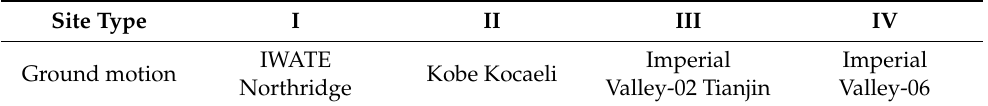
Table 2. Site types of the ground